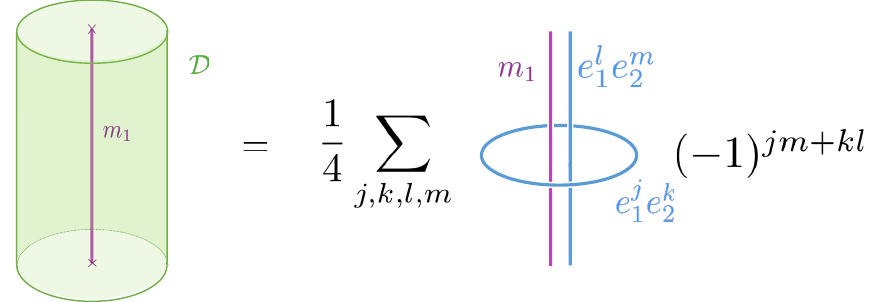
Figure 27: The condensation defect acts on m a cylinder in a 3D spatial